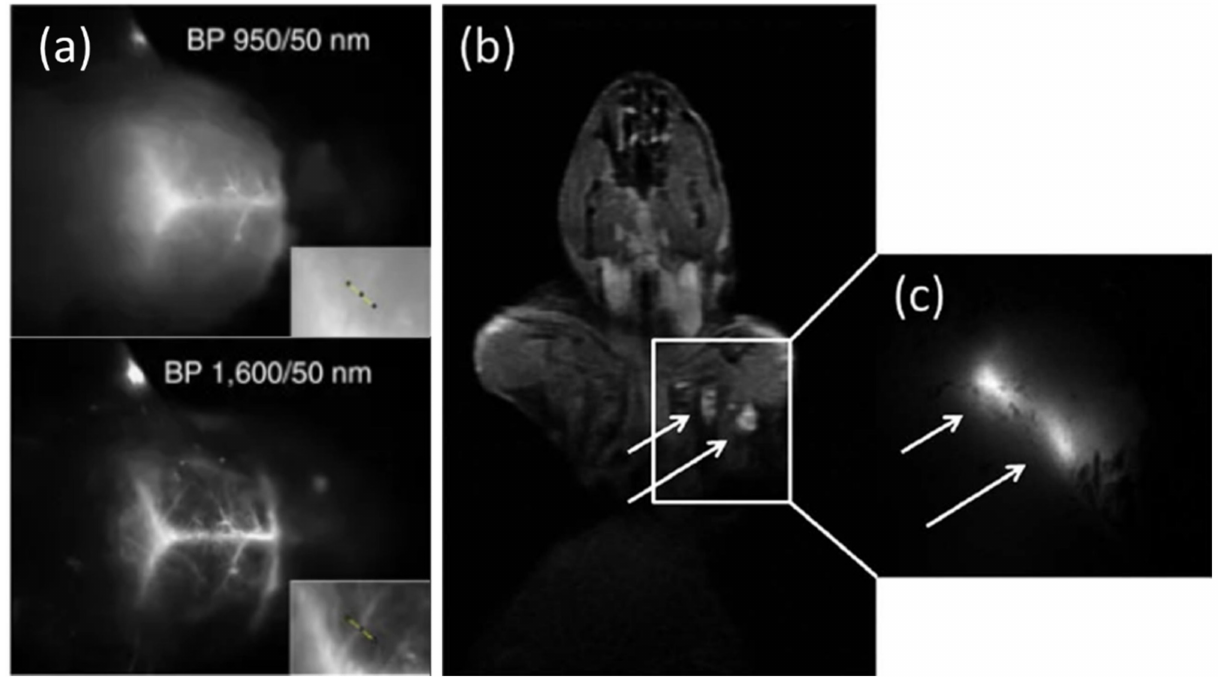
Figure 3. ( a ) Fluorescence imaging of the brain vasculature through intact skin and skull using SWIR emitting QDs with bandpass (BP) filters centered around 950 nm and 1600 nm, showing the improvement in spatial resolution at longer wavelengths. Reproduced with permission from Nature Publishing Group [48]. ( b ) Multimodal detection of lymph nodes by T1-weighted MRI. ( c ) NIR fluorescence using subcutaneously injected Mn 2+ -doped CuInSe 2 QDs. Reproduced with permission from the Royal Society of Chemistry